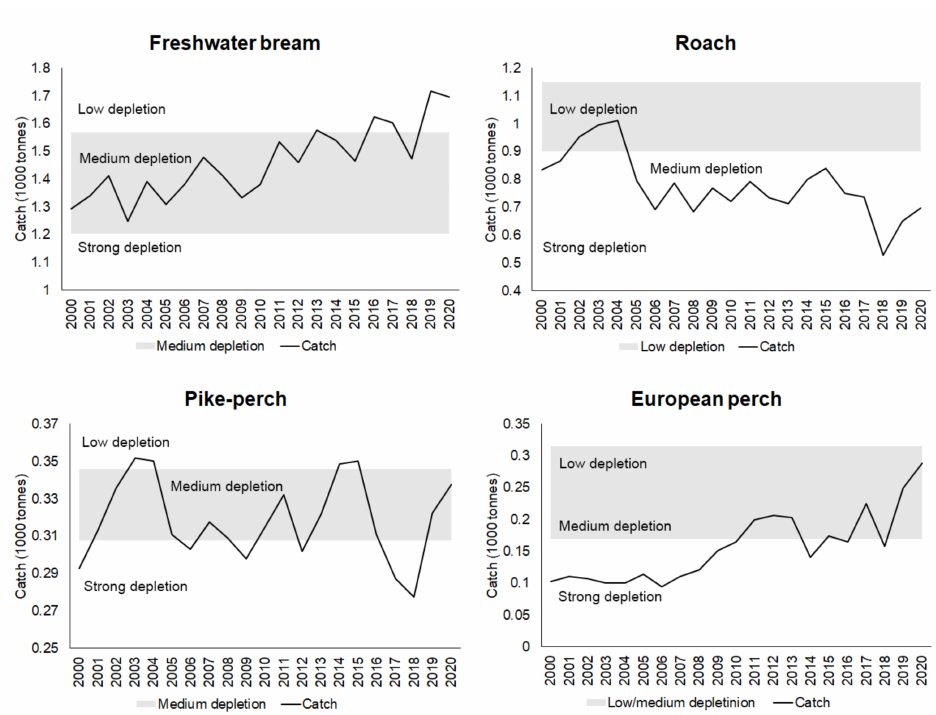
Figure 3. Status for 2000–2020 by species according to 1 and 3 quartiles of catches of the 1969– 1990